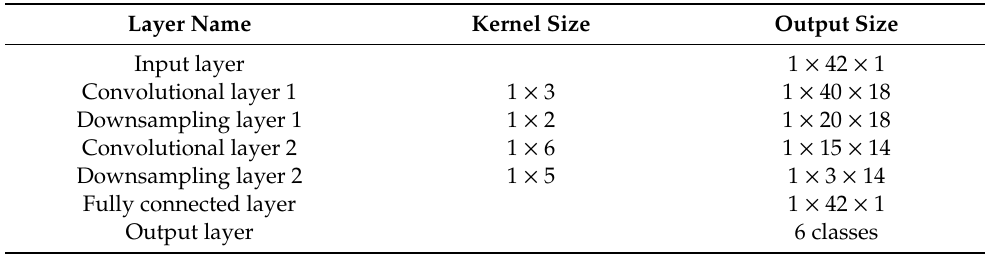
Table 1. The parameters of the CNN